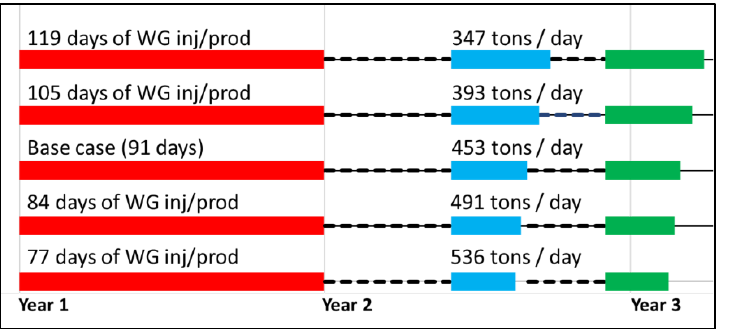
Figure 2. The WG inj/prod duration sensitivity test. The figure shows the CG injection duration (red), the WG injection (blue) and production (green) duration of the base case and the sensitivity tests on a timeline. The rest times are shown as black dashed lines. Additionally, the adjusted target injection and production rates are provided.